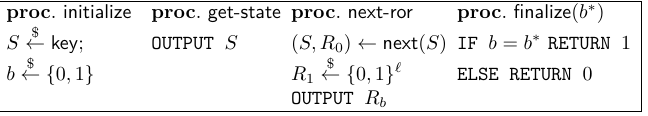
Figure 4: Procedures in Security Game